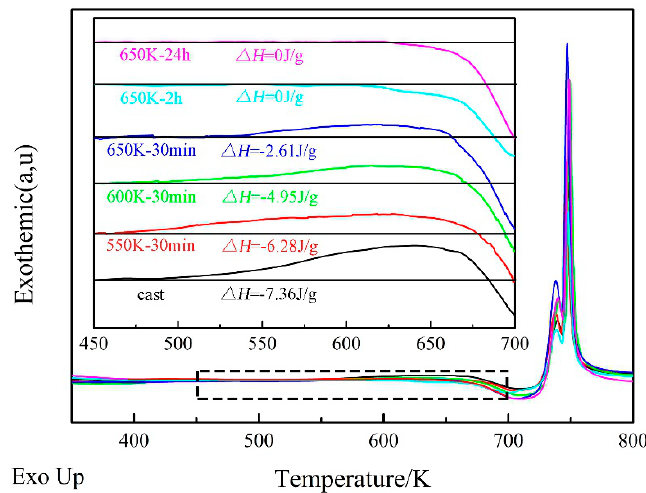
Figure 2. Differential scanning calorimetry curves of all the samples, the inset shows the different exothermic signals before the glass transition.